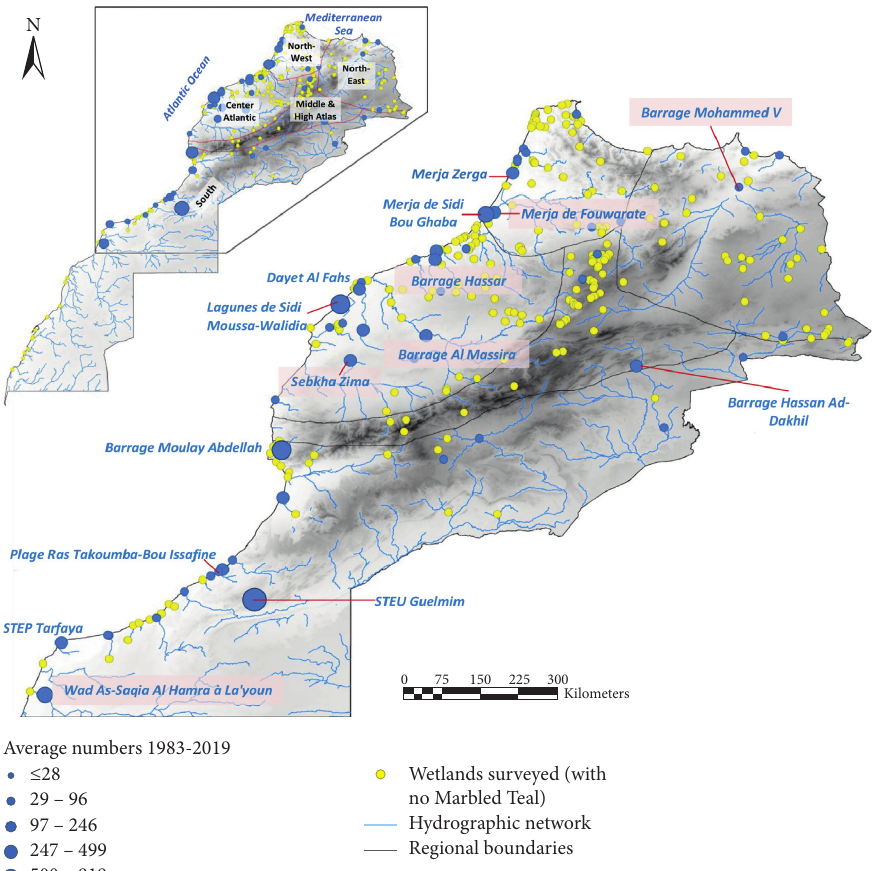
Figure 5: Distribution map of the Marbled Teal’s wintering population in Morocco